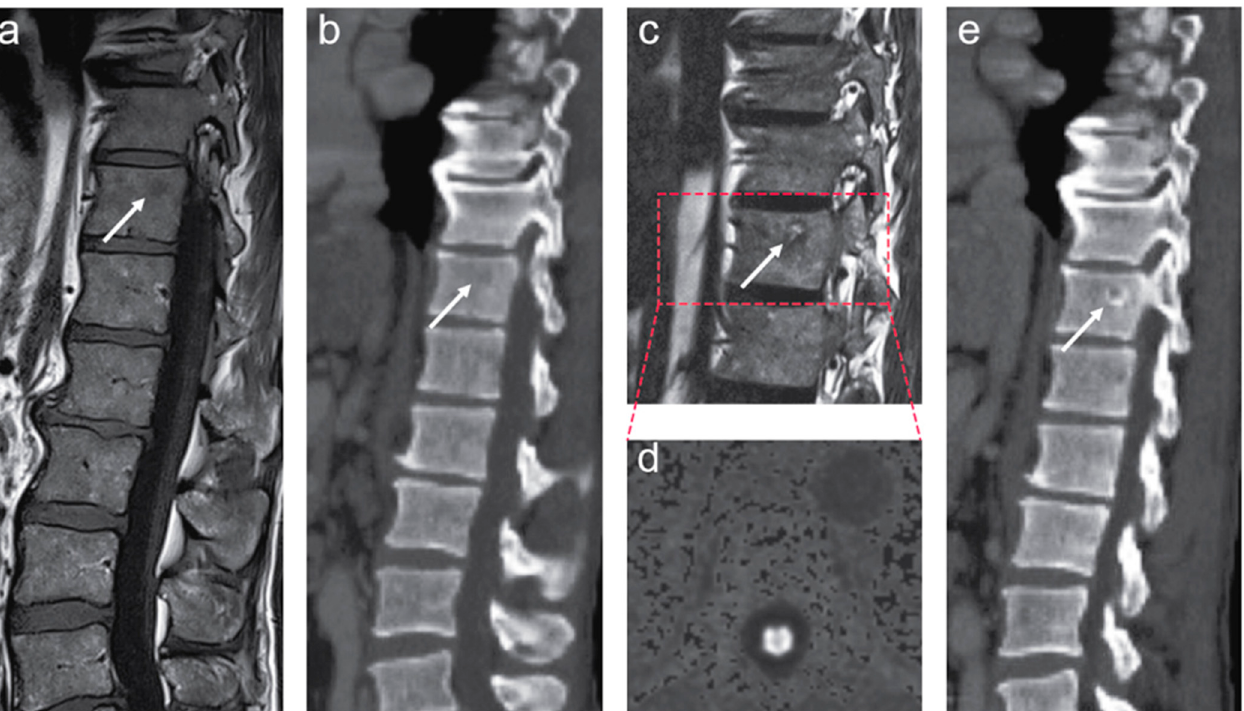
Figure 2. The left panel ( a , b ) shows pretreatment magnetic resonance imaging (MRI) and computed tomography (CT) scans of the thoracolumbar spine. Small, focal lesion in the thoracic spine is shown on MR ( a , white arrow) and CT ( b , white arrow) images. The right panel ( c – e ) shows follow-up MRI and CT performed after the start of combined androgen deprivation therapy. A sagittal T2-weighted fat-only Dixon image demonstrates an increased fat signal within the suspected lesion in the thoracic spine ( c , white arrow). There was no evidence of tumor activity on the diffusion-weighted MRI (DW-MRI) ( d ). CT of the thoracolumbar spine showed subtle perilesional sclerosis ( e , white arrow). The findings ( c – e ) have appeared since the pretreatment MRI and CT scans and are presumably consistent with the treatment effect in solitary bone marrow metastasis.